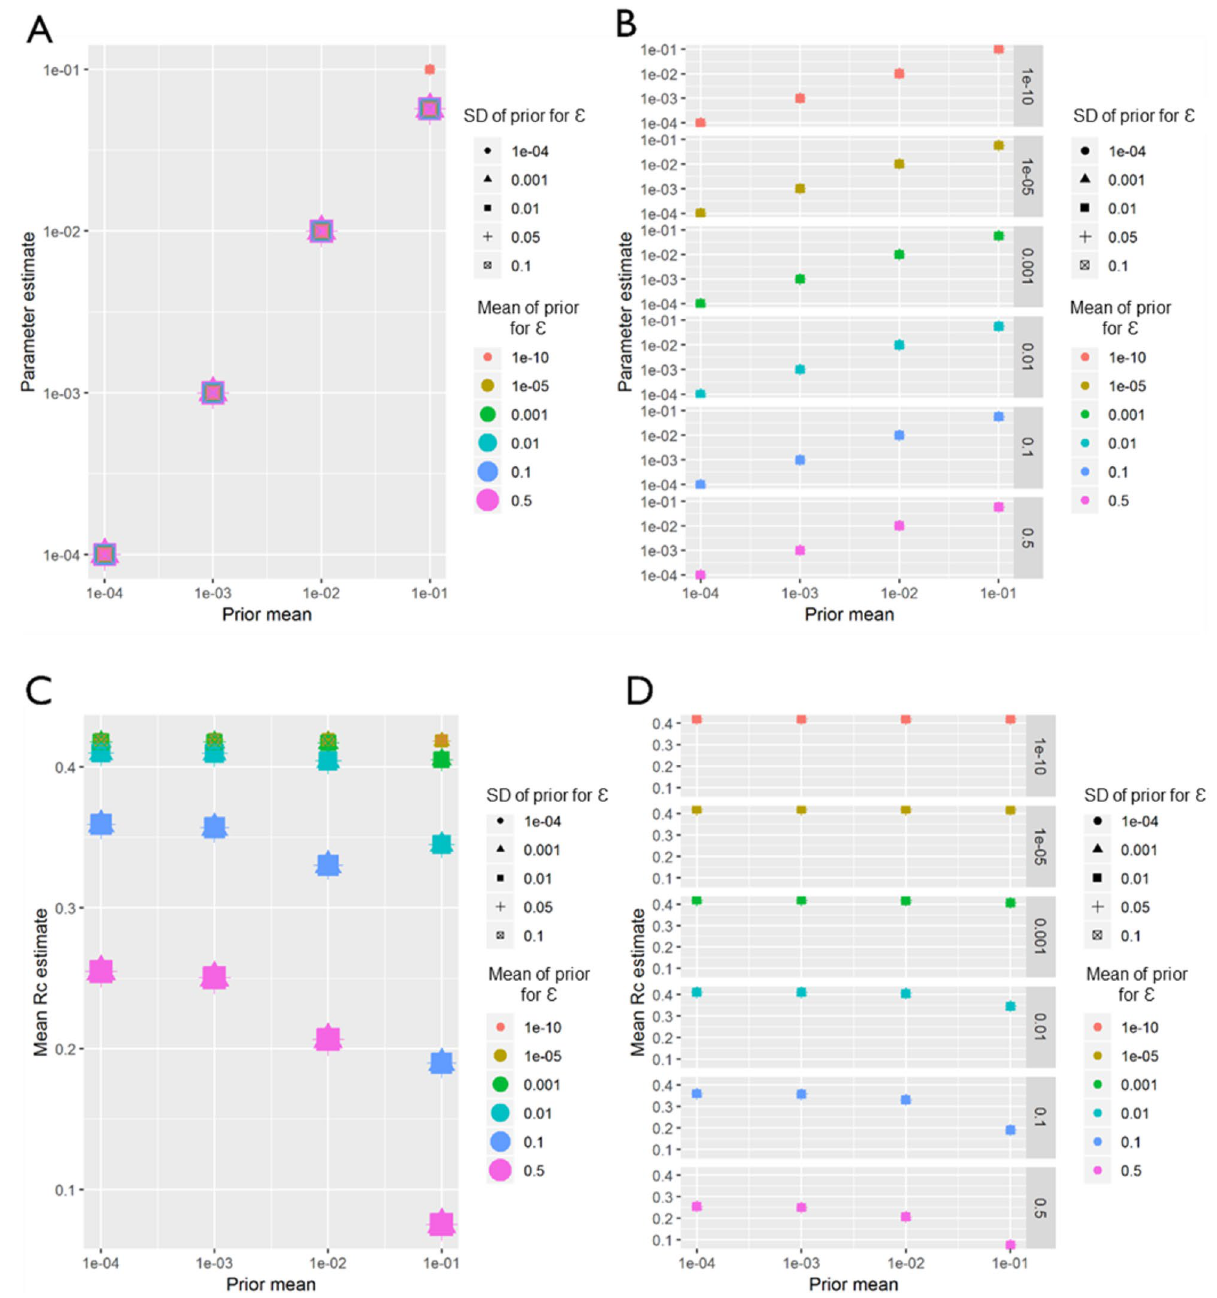
Figure 10. Eswatini sensitivity analysis. Sensitivity analysis showing the impact of varying the prior means for Eswatini. Sensitivity analysis showing the impact of varying the prior mean for the distance kernel shaping parameter, β. The different colours and shapes represent different means and standard deviations respectively of the normally-distributed prior of epsilon, ε, which represents shapes represent different hazards of infection by an external, unobserved source. For ( A) –( D) , the x-axis represents the prior mean used for β. ( A ) the y-axis shows the maximum a posteriori parameter estimate for the parameter β. ( B ) shows the same results, stratified by the prior mean of ε for clarity. ( C ) Shows the impact of priors for β and ε on the mean Rc estimate, and again ( D ) shows the same result, stratified by the prior mean of